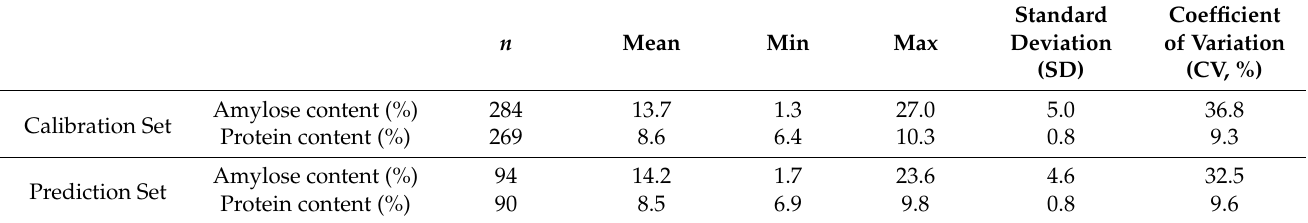
Table 1. Statistics of amylose content and protein content of NIR single-grain composition models.